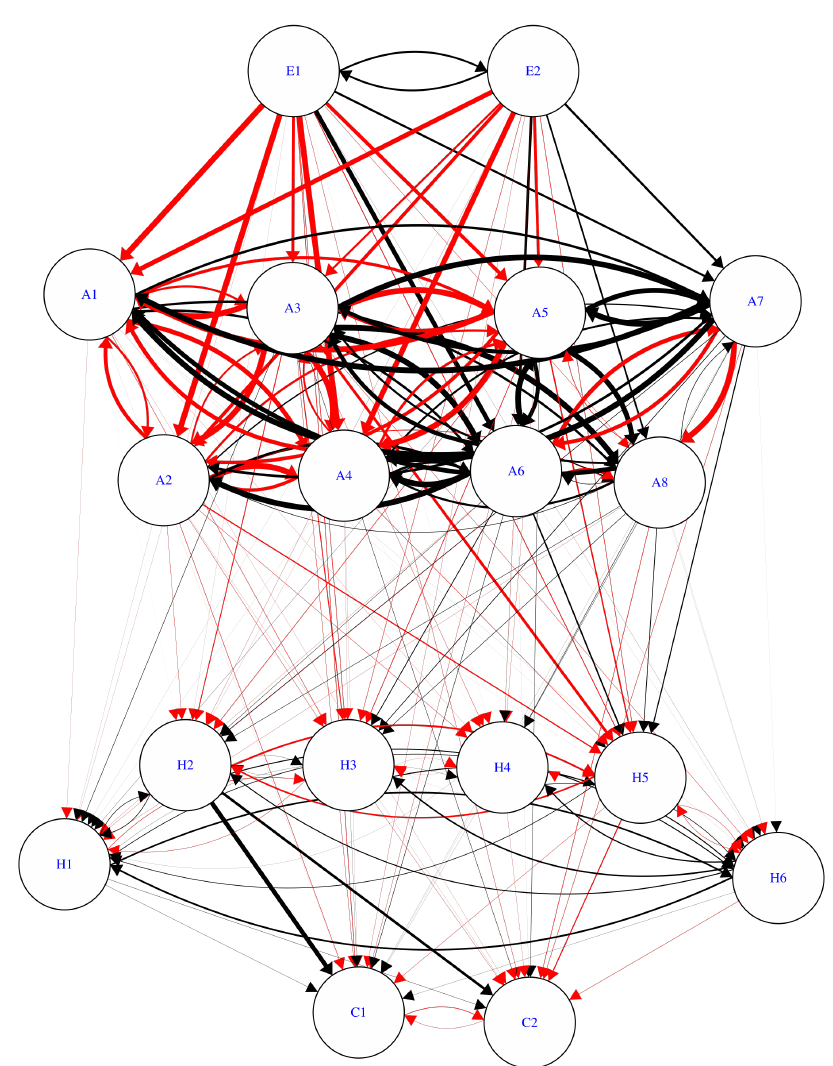
Figure 1. FCM with initial weight